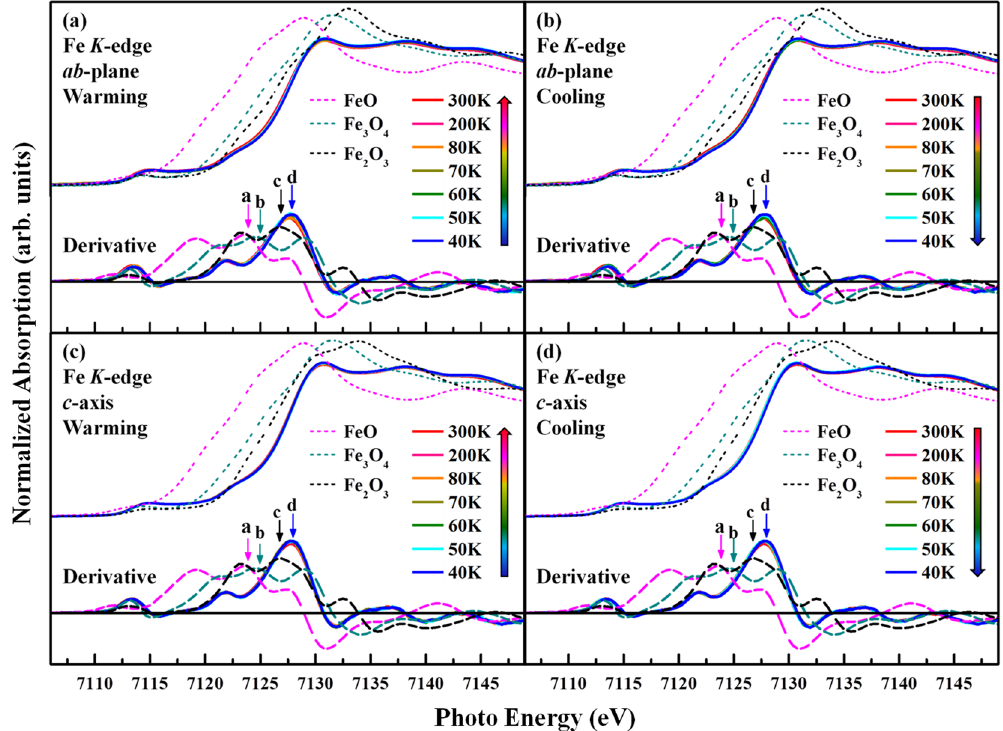
Figure 3. ( a–d ) The temperature-dependent Fe K -edge XANES spectra of single crystal SrFeO 2.81 measured at two different angles of incidence θ = 0° (with electric field E parallel to the ab -plane) and 70° (with electric field E nearly parallel to the c -axis) on warming and cooling process. Corresponding spectra were obtained for FeO, Fe 3 O 4 , and Fe 2 O 3 powder samples at room temperature with angle θ = 0° for